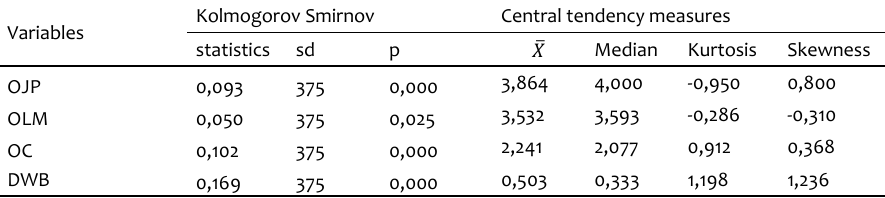
Table 1. Findings of the Distribution of Data